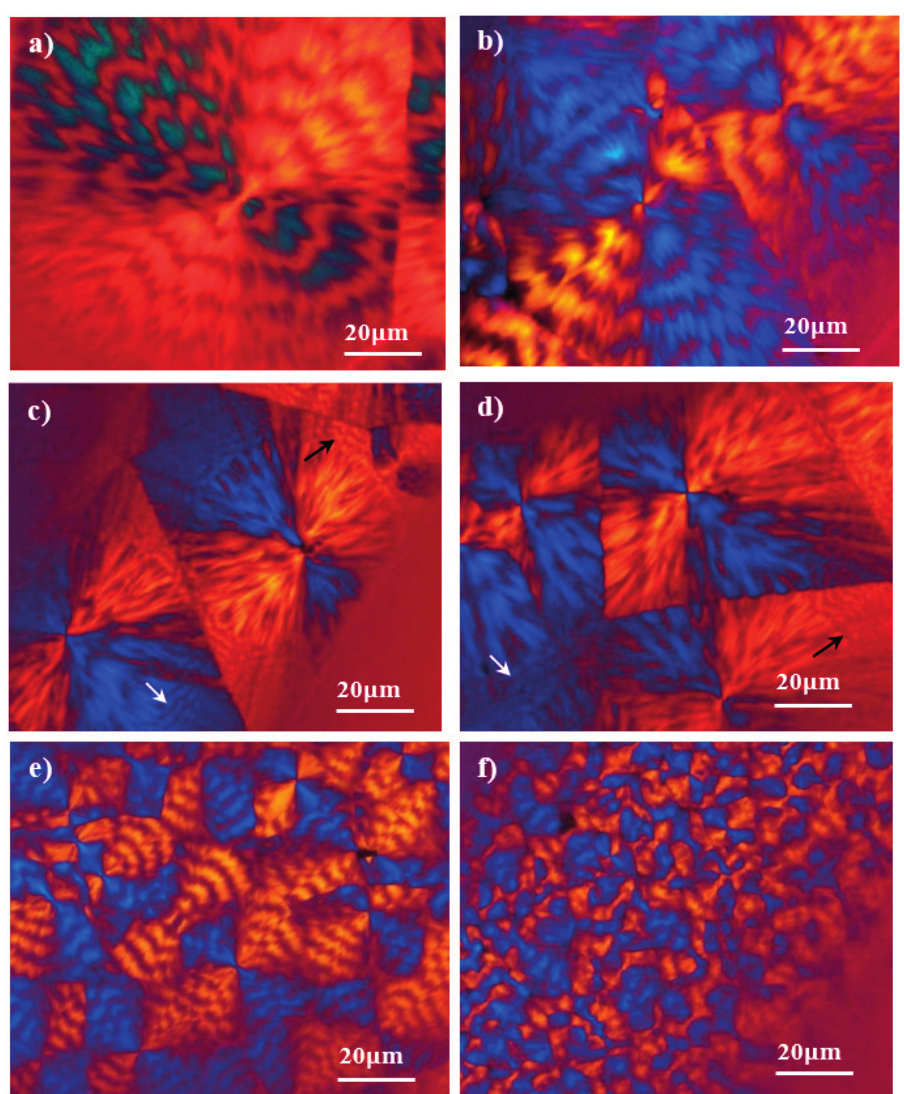
Figure 13. Optical micrographs of PE99 ( a , c , e ) and PE99-N 3 ( b , d , f ) spherulites isothermally grown at 60 °C ( a , b ); first step at 59 °C and second step at 54 °C ( c , d ); and 56 °C ( e , f ). Well-defined rings with interspacing between 3 and 2 μ m were detected (see arrows) in the outer part of spherulites grown at 54